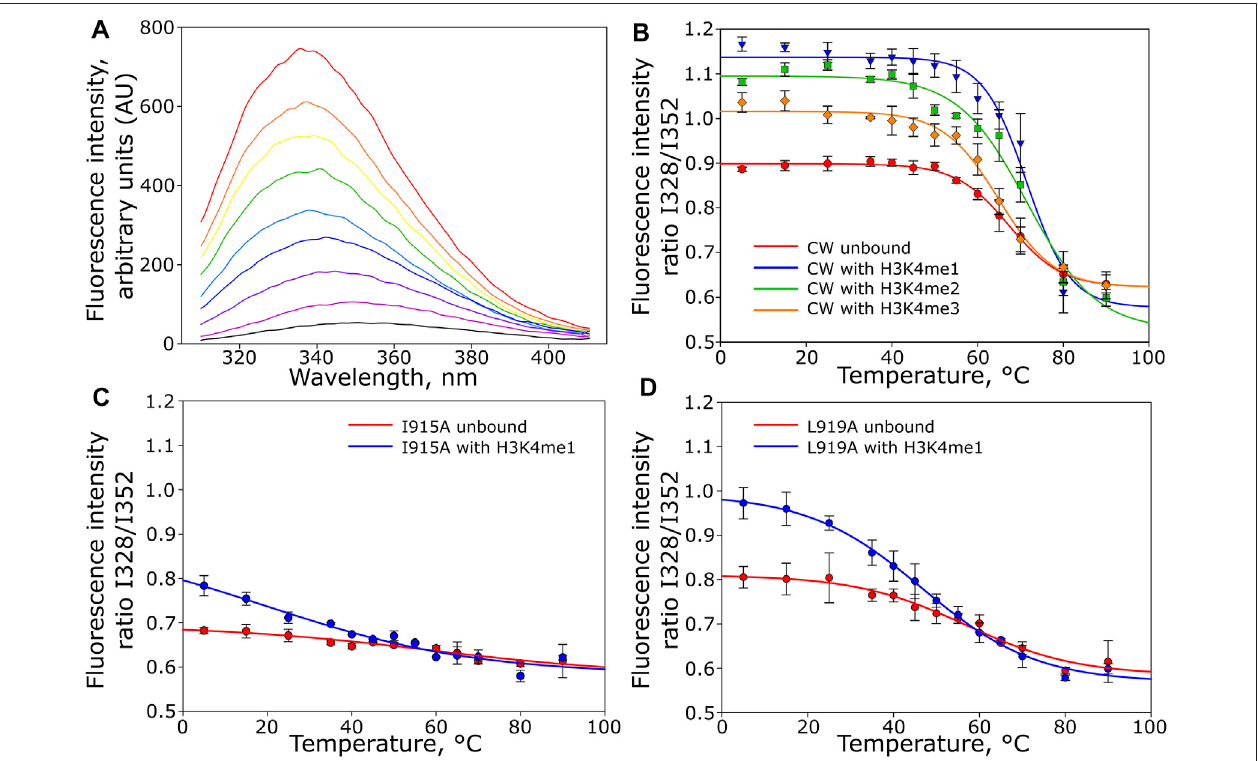
FIGURE 4 | Thermal denaturation of CW monitor by intrinsic tryptophan fl uorescence in unbound and bound states. (A) Representative fl uorescence traces for wild-type CW bound to H3K4me1 (only selected traces are shown), rainbow colors indicate temperature increase from 5 ° C (black) to 90 ° C (red). (B) melting curves for the unbound CWdomain ( ) andCW domain inthepresenceofH3K4me1 ( ),H3K4me2 ( ),and H3K4me3 ( )peptides; (C) melting curves forthe unboundCW I915Amutant( )andinthepresenceofH3K4me1peptide( );and (D) meltingcurvesfortheunboundCWL919Amutant( )andinthepresenceofH3K4me1 peptide ( ). Number of replicates =